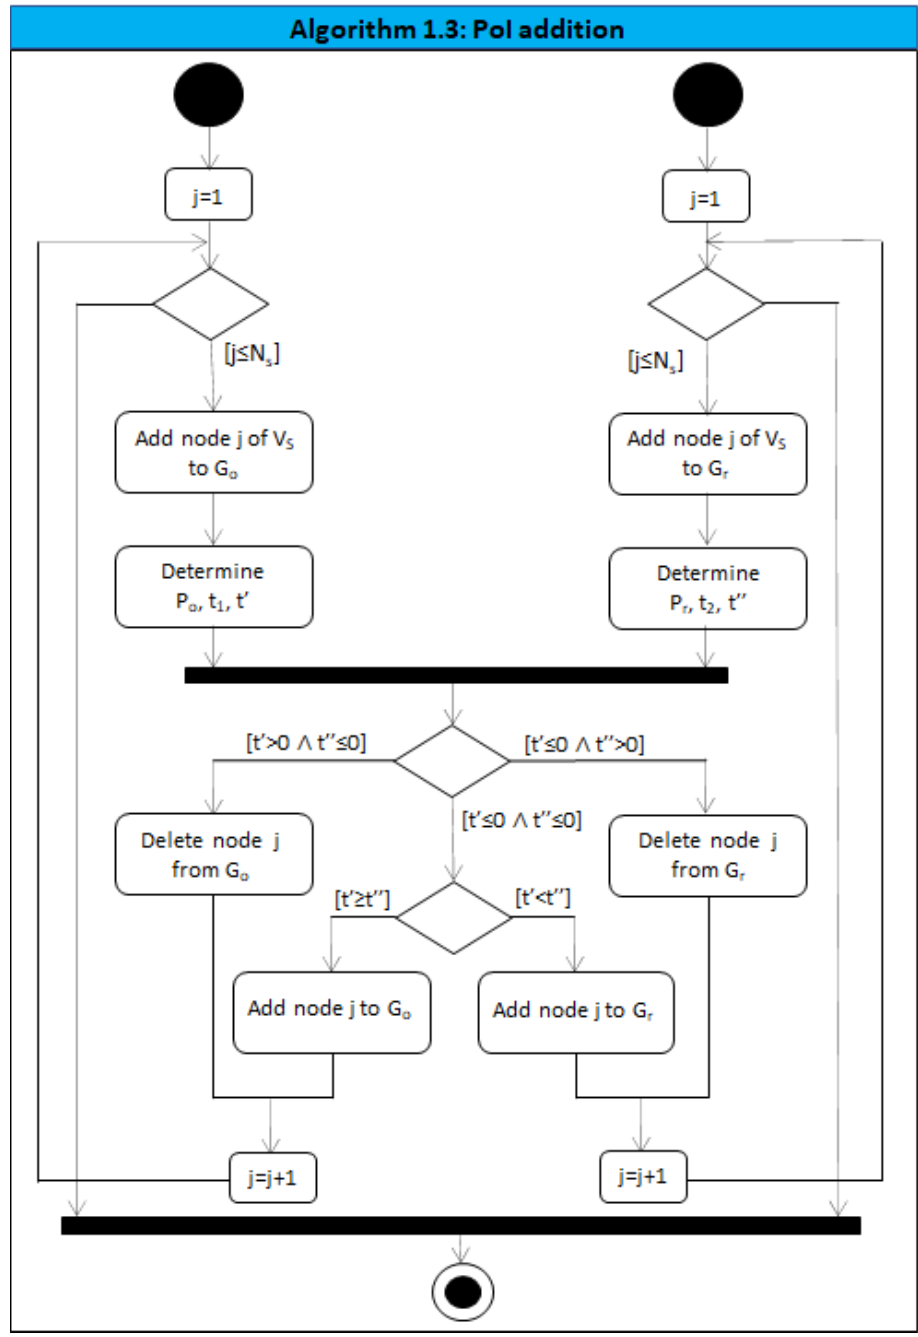
Figure 5. The UML diagram for the node addition